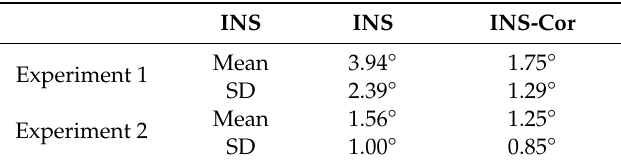
Figure 8. INS-Cor tracking paths. Table 5. Orientation